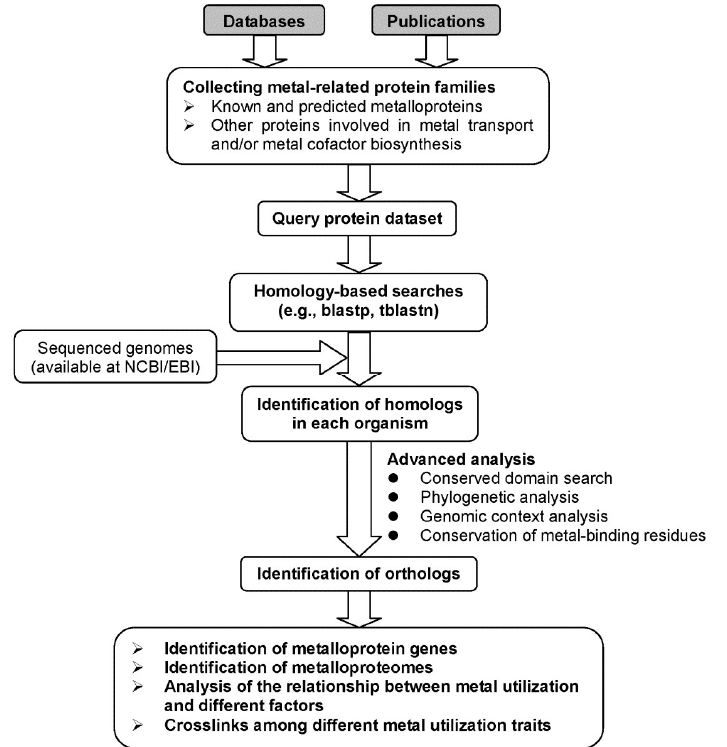
Figure 1. A general diagram for comparative genomic analysis of metal utilization.